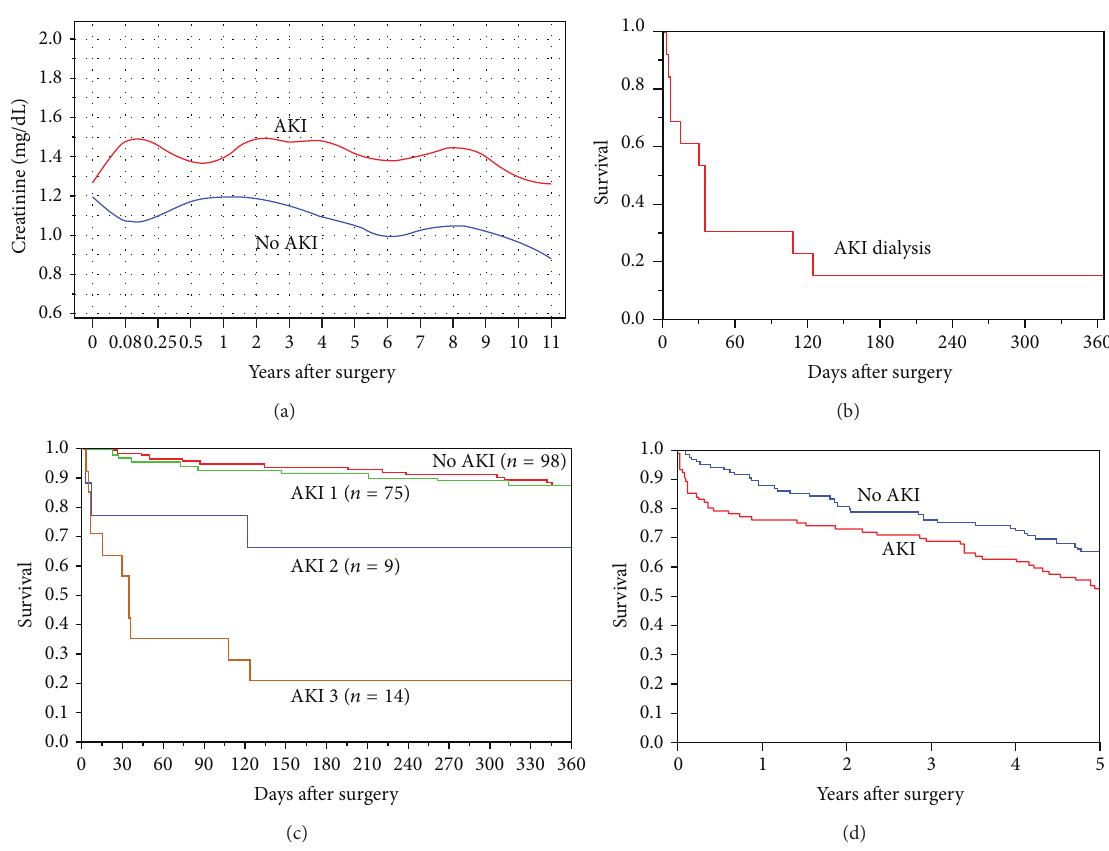
Figure 2: Patient survival. (a) Long-term s.Cr in AKI and non-AKI octogenarians. (b) Kaplan-Meier 1-year survival in octogenarians with AKI requiring dialysis ( 𝑛 = 13 ). (c) Kaplan-Meier 1-year survival by AKI Stages versus non-AKI, unadjusted log-rank 𝑝 < 0.0001 . (d) Kaplan- Meier survival curves, AKI versus non-AKI patients, log-rank 𝑝 = 0.016 . The adjusted a HR for AKI 2.02; 95% CI 1.01–4.04, 𝑝 = 0.04 .